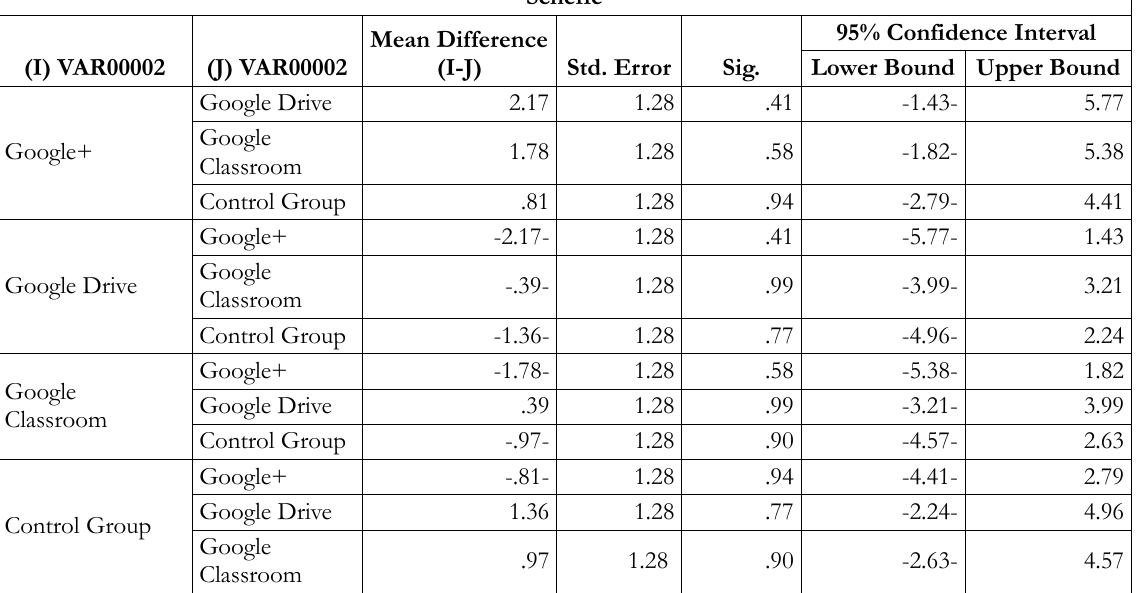
Table 2. Multiple Comparisons result for the pre-test